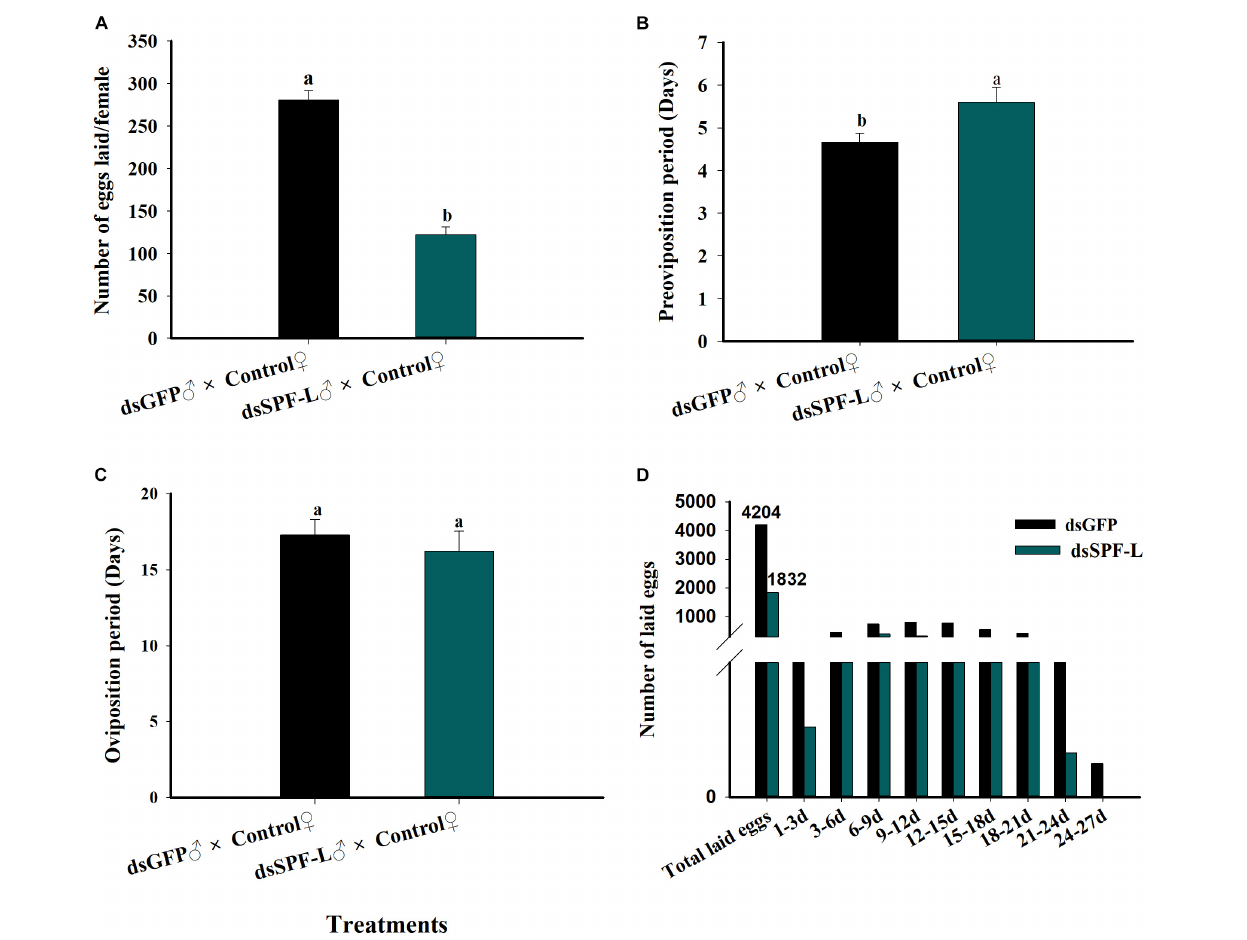
FIGURE 9 | Influence of mating with dsSPF-L treated males on female reproductive parameters. (A) The histogram bars show mean numbers of eggs deposited ( n = 15 independent biological replicates). (B) The histogram bars show duration of the pre-oviposition period (days) ( n = 15 independent biological replicates). (C) The histogram bars show the duration of the oviposition period (days) ( n = 15 independent biological replicates). (D) The histogram bars show numbers of eggs deposited during the indicated oviposition intervals in days. n = 15 mating pairs. The histogram bars with different letters are significant difference at p < 0.05 (Student’s t